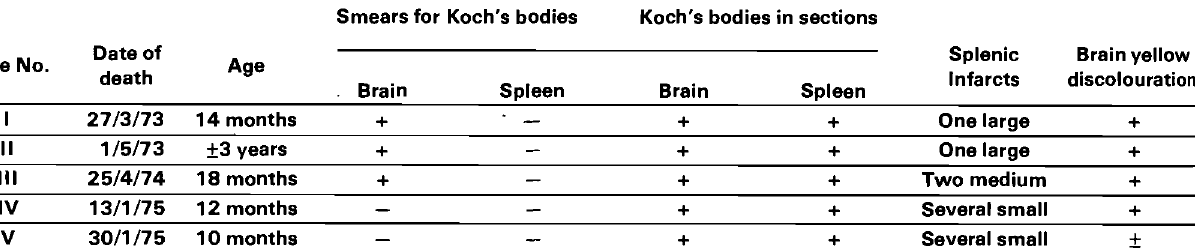
Table 1: POST MORTEM FINDINGS IN FIVE CASES OF BOVINE CEREBRAL THEILERIOSIS